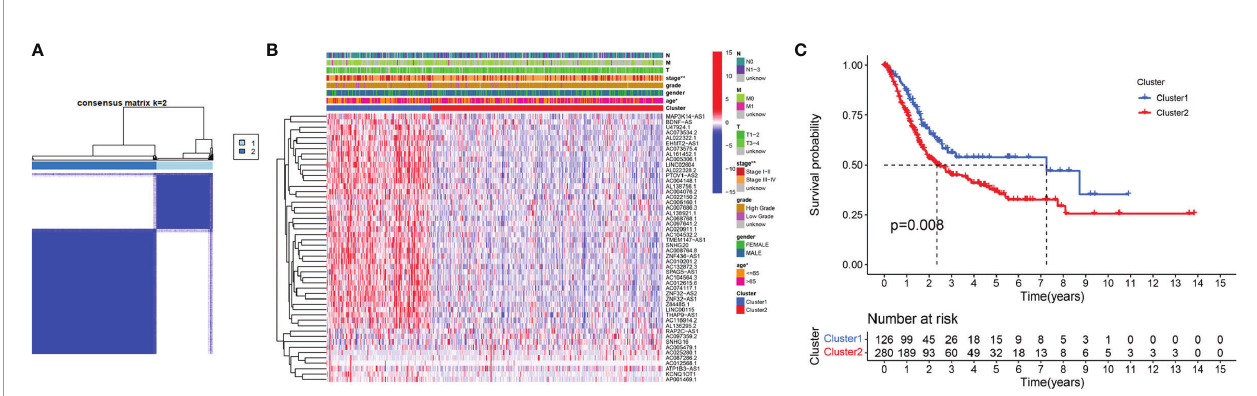
FIGURE 3 | Differential clinicopathological features and survival rates of BC patients in cluster 1 and cluster 2. (A) Consensus clustering matrix for k = 2. (B) The heatmap of cluster 1 and cluster 2 along with clinicopathological features that included gender, age, grade, T stage, N stage, M stage, and stage. (C) Kaplan-Meier curves of OS. * P < 0.05 and ** P